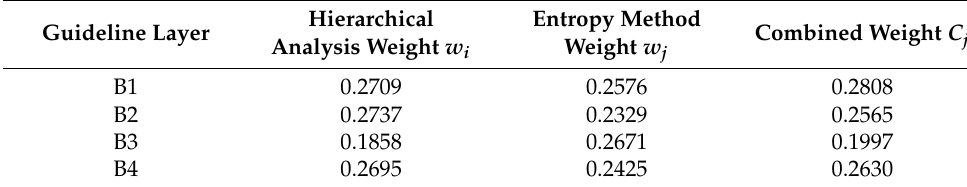
Table 14. Comprehensive weight results (criterion layer) obtained using two weighting methods. Guideline Layer